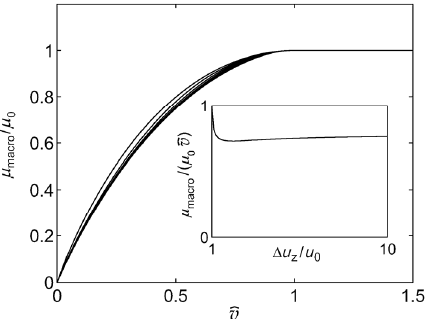
Fig. 5 Dependence of the normalized coefficient of friction on the dimensionless velocity v (3) for the “jumping” case, i.e., when the oscillation amplitude exceeds the average indentation depth. Curves are shown for 11 oscillation amplitudes from / 1 / 2 u u   to u u   with a step of 0.1 . The curves for ,0 z z ,0 z z higher oscillation amplitudes “pile up” towards a limiting curve. The inset shows the dependence of the slope of the low-velocity / asymptote (21) on u u  . One can see that it depends only ,0 z z weakly on the oscillation amplitude: Once the sample starts jumping the slope drops rapidly by about 20% and then remains practically constant with a limiting value of π /4